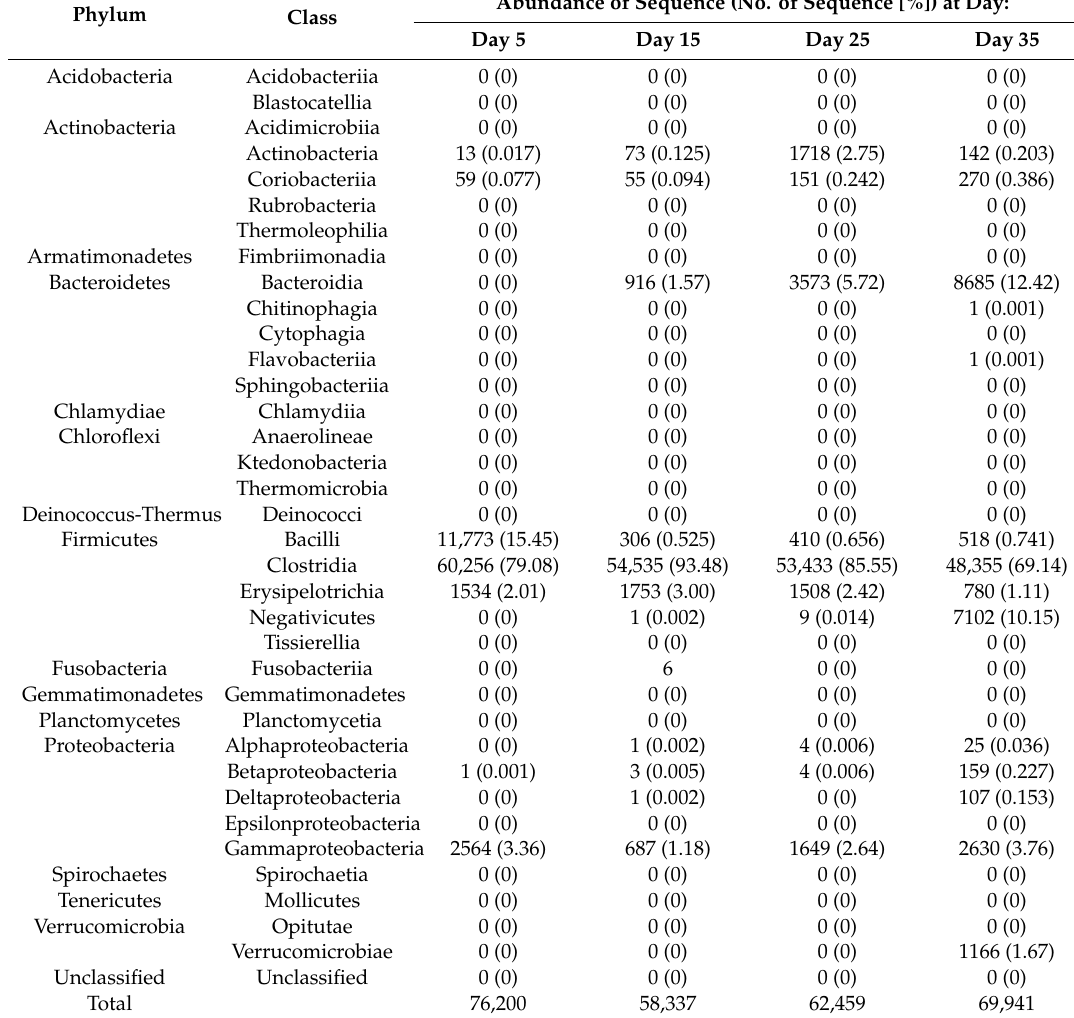
Table 10. Abundance of bacterial 16S rDNA sequences ( n = 266,937) isolated from the cecum microbiota of Omani